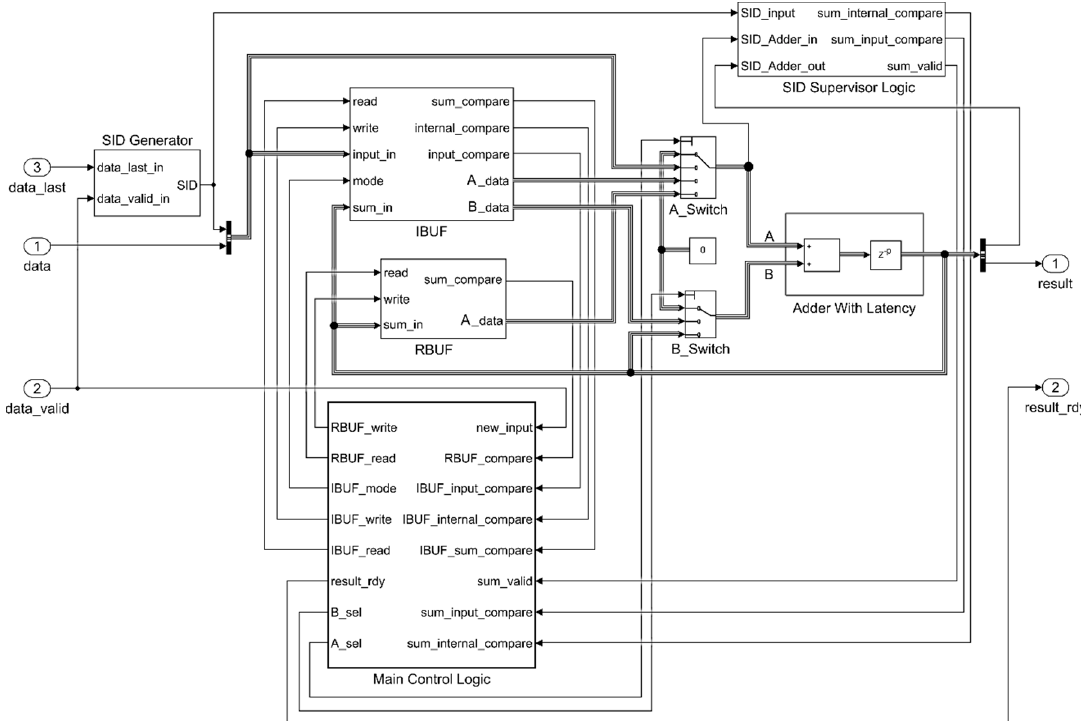
ff ering (DB) accumulator Figure 1. Simulink multi-set delayed buffering (DB) accumulator implementation. Figure 1. Simulink multi-set delayed bu